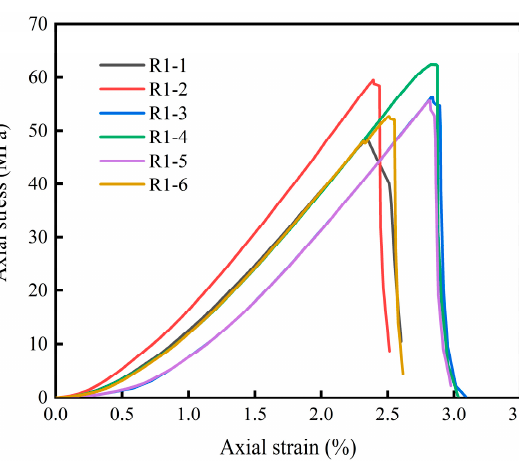
Figure 9. Stress–strain curve of the UCS test.